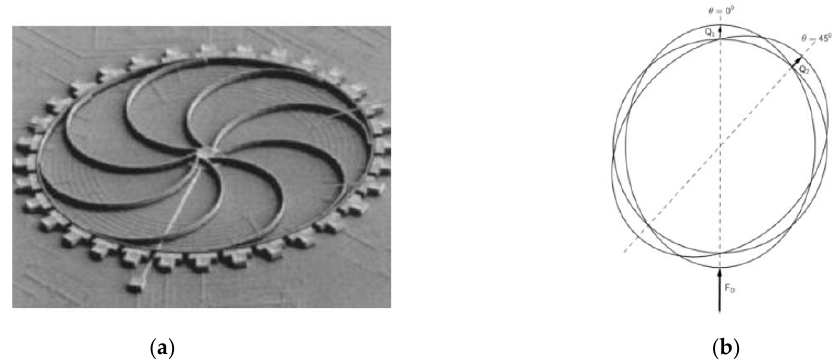
Figure 1. ( a ) Typical configuration for ring-based CVG having 8 support spokes [3]; ( b ) For devices operating using 2 (cid:2016) in-plane flexural responses, the drive mode is excited at resonance by applying a harmonic drive force; rotation about the ring polar axis induces the sense mode to vibrate, aligned 45 degrees to the drive